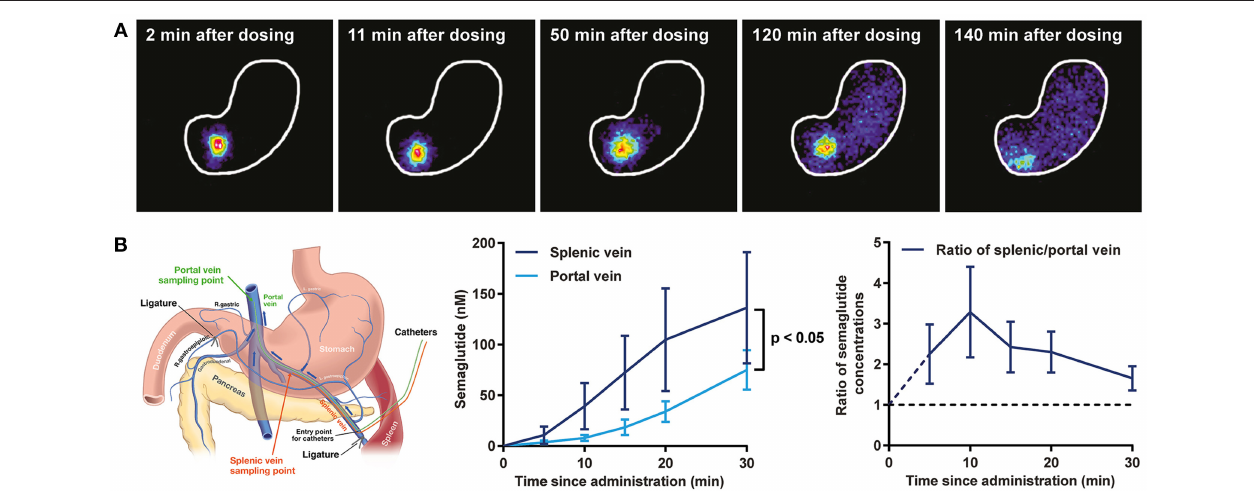
FIGURE 12 | Anatomical site of absorption of oral semaglutide. (A) Gamma scintigraphic imaging of tablet erosion in the stomach from 2 to 140min after a single dose of oral semaglutide (10mg) in a representative healthy individual. White line outlines the stomach; colors within the stomach (red/yellow/green/blue) represent the tablet core and released radioactivity. (B) Illustration of the splenic vein, which drains the gastric cavity, and the portal vein, which drains the gastrointestinal system. Mean semaglutide plasma concentration–time profiles in the splenic and portal veins after a single dose of oral semaglutide (10mg) in beagle dogs ( n = 15). R. gastric, right gastric; L. gastric, left gastric; R. gastroepiploic, right gastroepiploic; L. gastroepiploic, left gastroepiploic. The ratio and 95% CI of the splenic vs. portal veins for AUC 0 − 30min were calculated [1.94 (1.15 to 2.74)], and statistical significance was determined on the basis of a null hypothesis value of 1 ( p < 0.05). The horizontal dashed line (right) represents similar semaglutide plasma concentrations in the splenic and portal veins. Error bars show ± SEM calculated on the original scale or calculated on a log-scale and back-transformed to the original scale. From Buckley et al. (262). Reprinted with permission from the American Association for the Advancement of Science (AAAS).